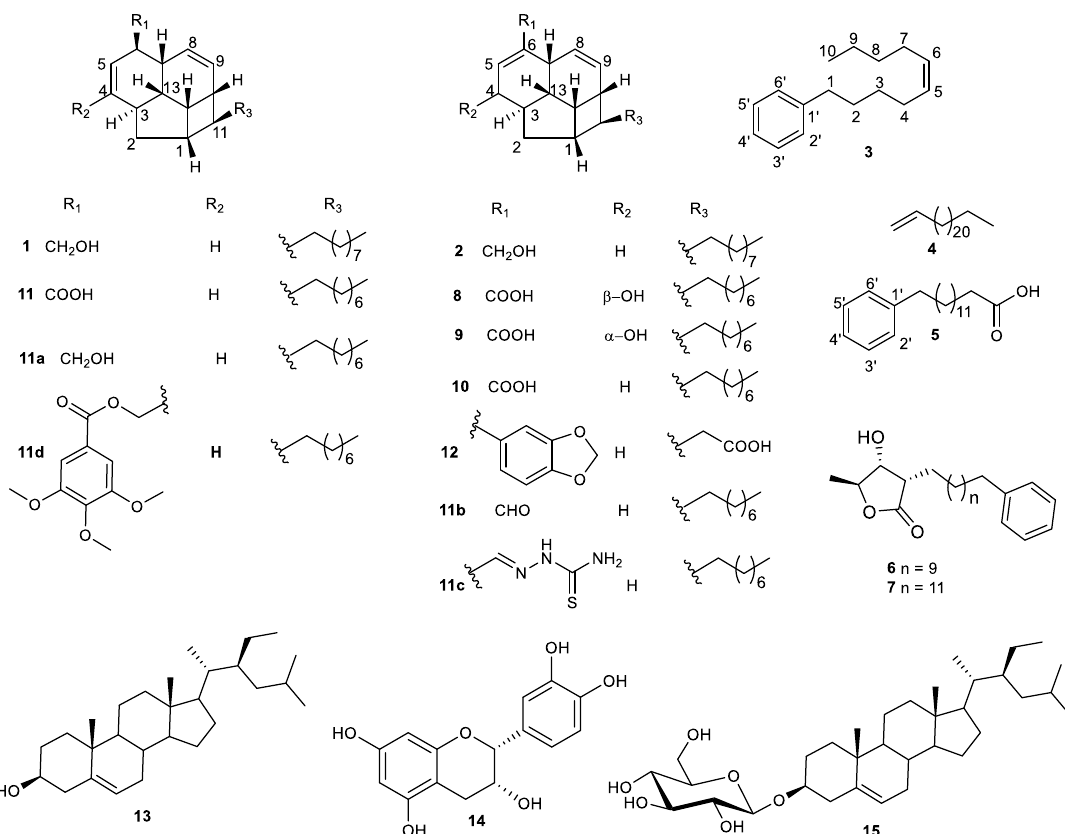
Figure 1. Isolated compounds from the roots of Beilschmiedia louisii and the stem bark of B. obscura ( 1 – 15 ) and semi-synthetic derivatives ( 11a – 11d ).